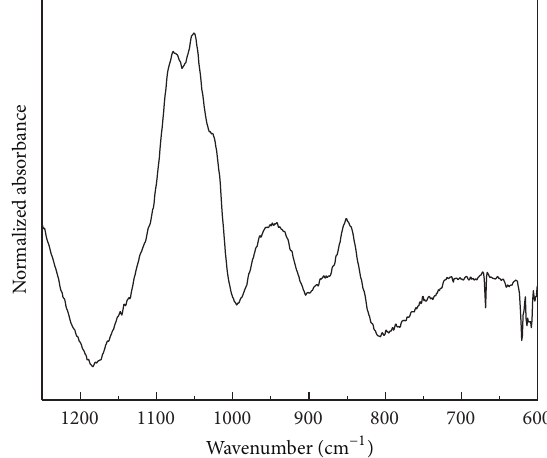
Figure 7: ATR-IR spectra of a CeO 2 /MMT nanocomposite elec- trodeposited film using potentiostatic conditions at 𝐸 = 1.10V and 25 ∘